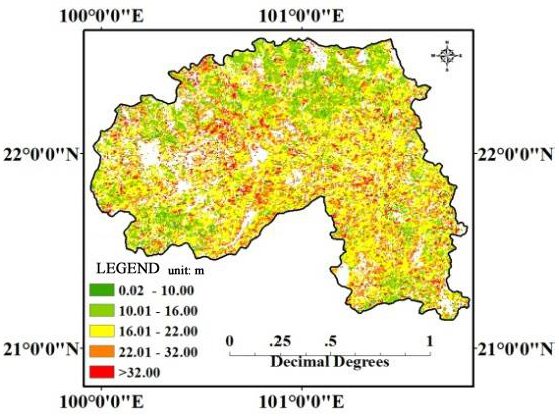
Figure 4. A map of forest canopy heights in Xishuangbanna.